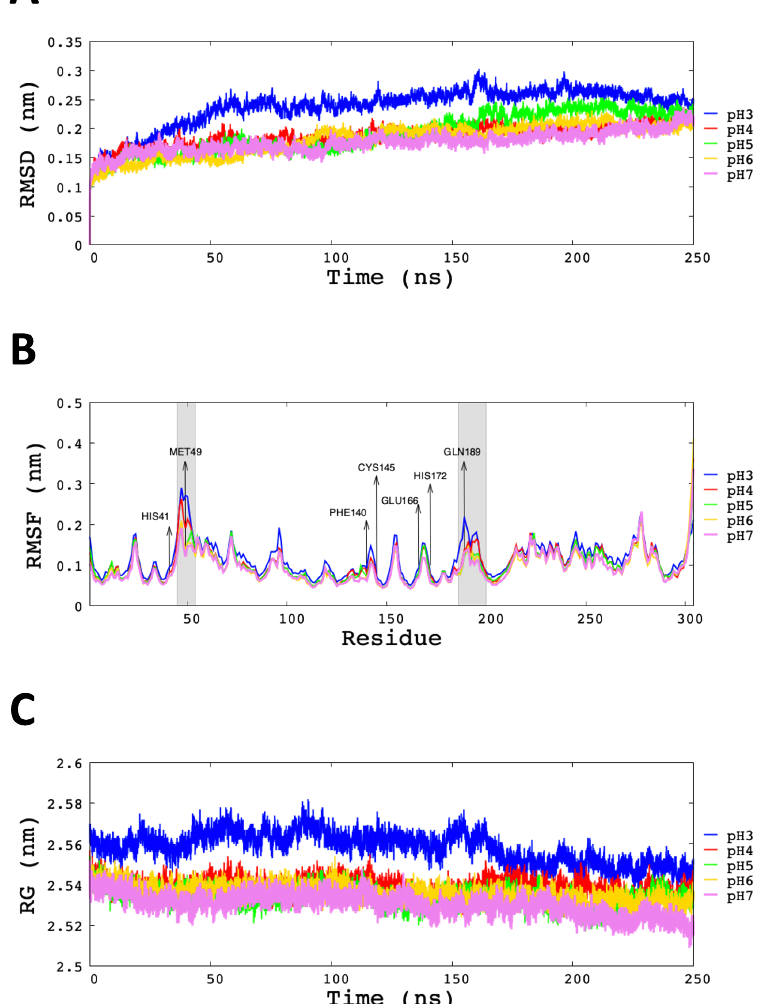
Figure 4. RMSD, RMSF and RG graph of backbone for each pH modelled. ( A ) RMSD presented as a function of time. ( B ) RMSF per residue of C- α , highlighting the most important residues of Mpro, during last 100 ns of MD simulations. ( C ) RG analysis of structural